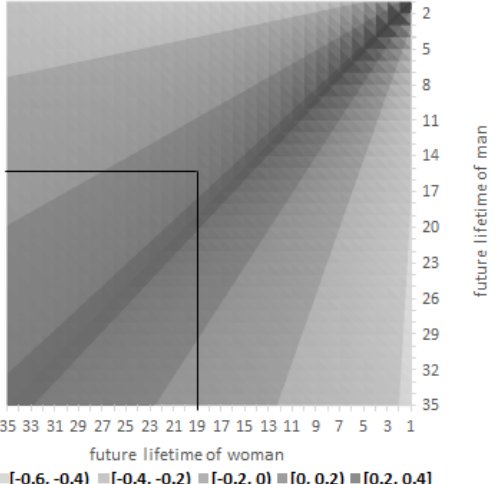
Figure 2. The relative increase in benefits in both variants for spouses aged 65. The dark colours indicate positive differences, i.e., a higher total benefit in the second variant. Lighter colours represent negative differences, which means a higher total pay- ment in the first option. The graphs also show lines that illustrate the future life expec- tancy of people at the considered age. The future life expectancy of a 65, 75, and 85-year- old woman is 19.04, 16.54, and 6.05 years, respectively, and for men of the same age it is 14.73, 9.22, and 5.2 years, respectively.